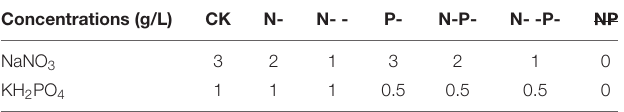
TABLE 1 | The initial concentrations of sodium nitrate and potassium dihydrogen phosphate in all media (g/L). Concentrations